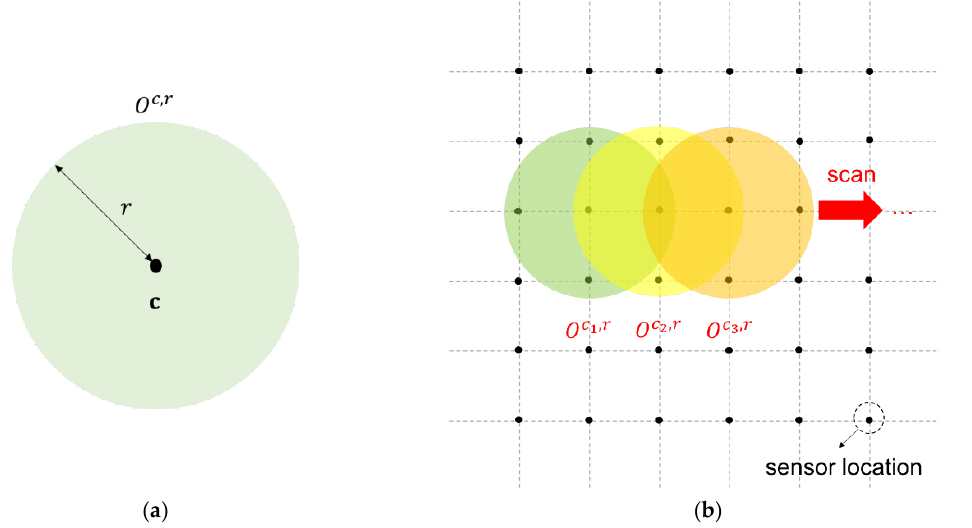
Figure 3. Illustration of the monitoring procedure for local spatial clusters using the spatial scanning method. ( a ) A local spatial cluster. ( b ) The spatial scanning procedure.